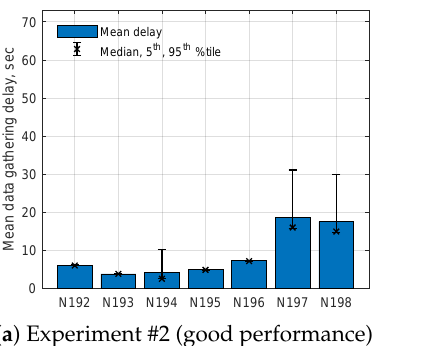
Figure 16. End-to-end packet delivery delays at the data gathering stage. Examples of ( a ) good and ( b ) poor